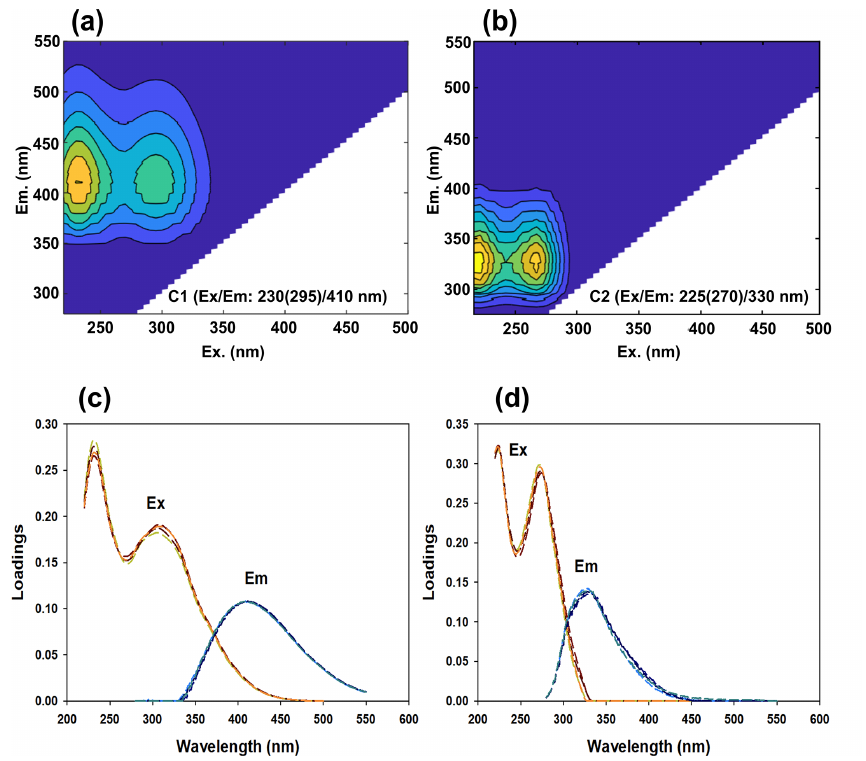
Figure 6. (a, b) Fluorescence EEM contour plots of the two fluorescent components C1 and C2 identified using EEM-PARAFAC for the fine-mode aerosols collected over the western Arctic Ocean during the summer of 2016. (c, d) The loading plots of C1 and C2 showing the split-half